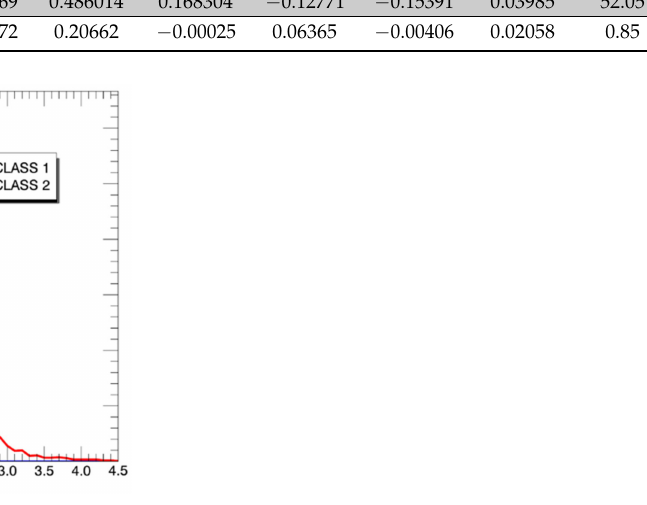
Figure 4. Probability density functions (pdf) of the two classes defined in Equation (5). The two pdf curves were computed for the training data sets (Table 1) and refer to case 2, which uses the AMSR2 measured minus expected specular surface emissivities as input. The x -axis values are the discriminant W T · X . The decision boundary d is at the intersection between the two pdf, which in this example is d =